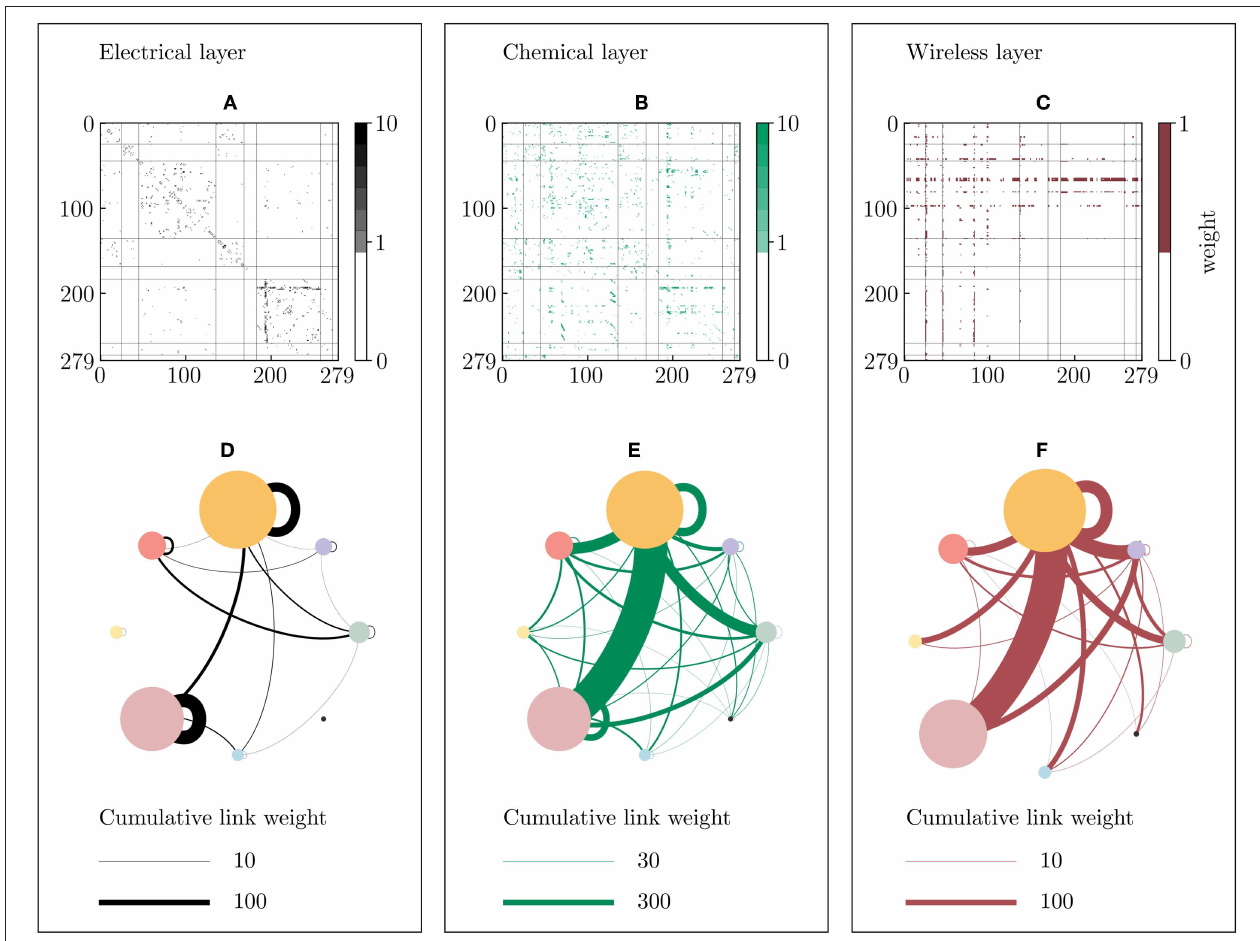
FIGURE 8 | Communities of the dynamical correlation-based C. elegans network. The network is divided into 8 communities of different size using the correlation matrices of the p -variable from the dynamical equations (see Methods 5.5). (A–C) Weighted adjacency matrices of the electrical (black), chemical (green) and wireless (red) sub-network, where the axes represent the nodes indices. The vertical and horizontal lines divides the matrix in the counter-clockwise ordered communities, from left to right in the horizontal axis, and from up to down in the vertical axis, respectively. Note that the maximum depicted weight is set to 10 in both the electrical and chemical layers for visualization reasons, even though few higher weights exist. (D–F) Inter- and intra-community coupling of the three layers, where colored circles represent communities [1: gray (25 neurons), 2: violet (20 neurons), 3: orange (91 neurons), 4: red (33 neurons), 5: yellow (15 neurons), 6: pink (75 neurons), 7: blue (14), 8: black (6 neurons)]. Electrical and chemical connections are shown as black and green lines, respectively. Wireless connections are colored in red. In this partition, edges are distributed more clearly than in the partition obtained from the Multilayer-Louvain approach in Figure 5